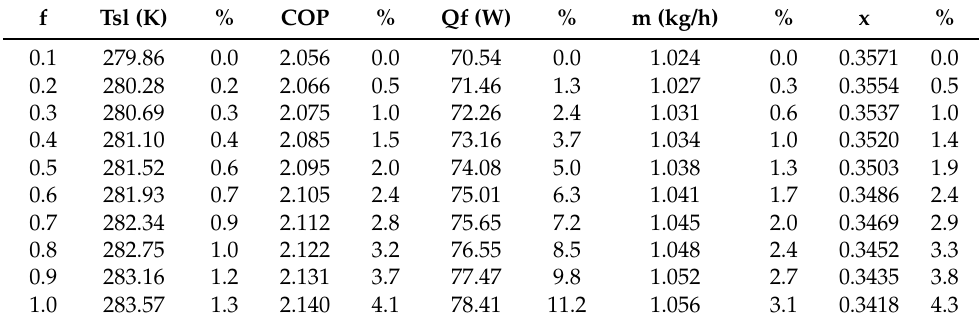
Table 2. Sensitivity analysis with respect to lateral heat transfer area. T cond = 54 °C, T evap = − 3.7 °C,